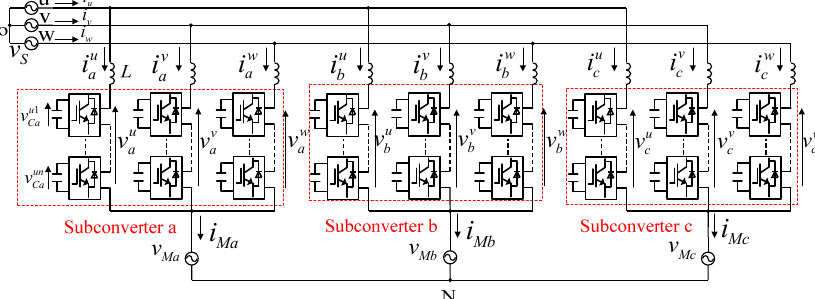
Figure 1. The topology of modular multilevel matrix converter (M 3 C).